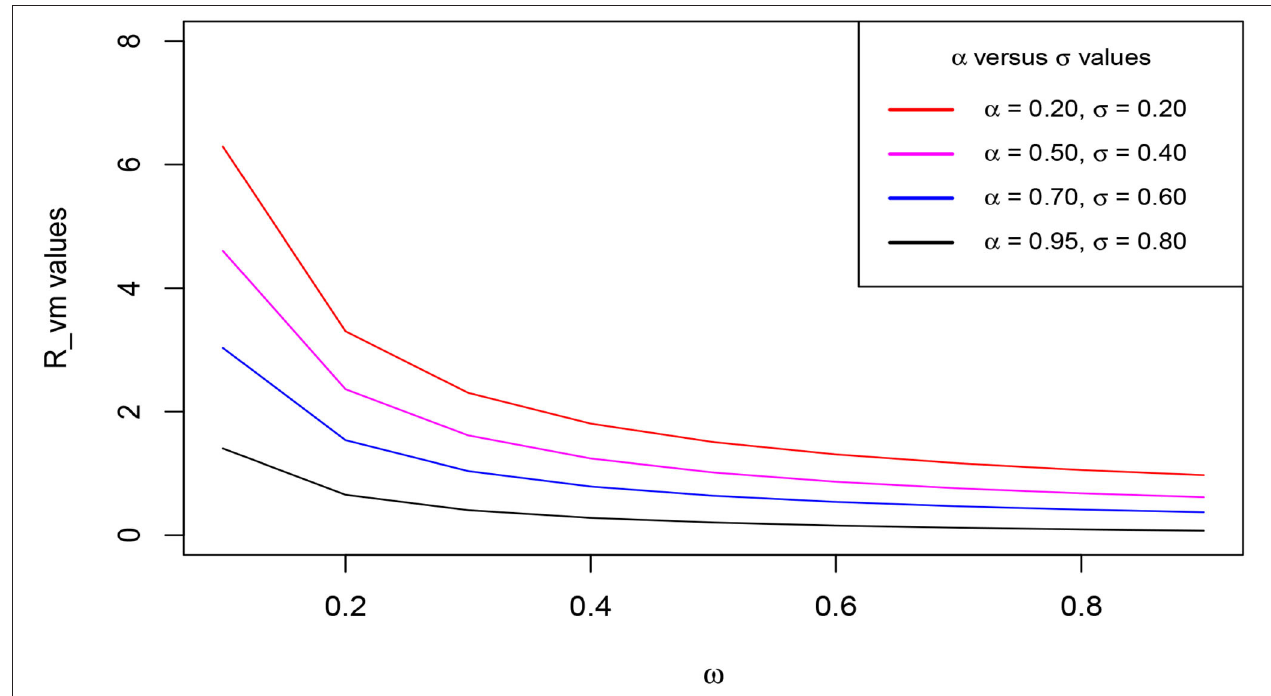
FIGURE 3 | Change of the reproduction number with ω as α and σ increase. Parameter values used are listed in Table 1